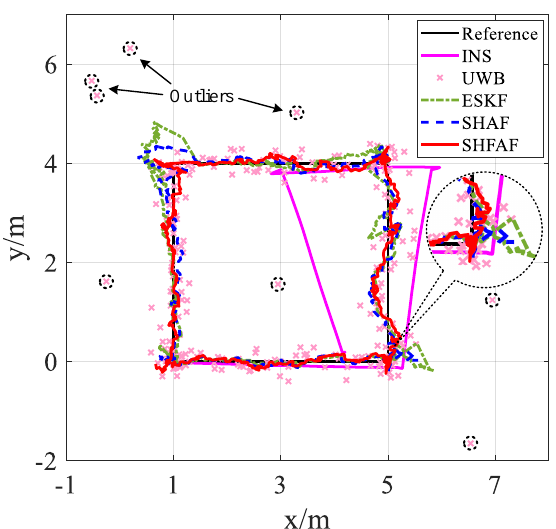
Figure 13. The positioning results of Trajectory B.